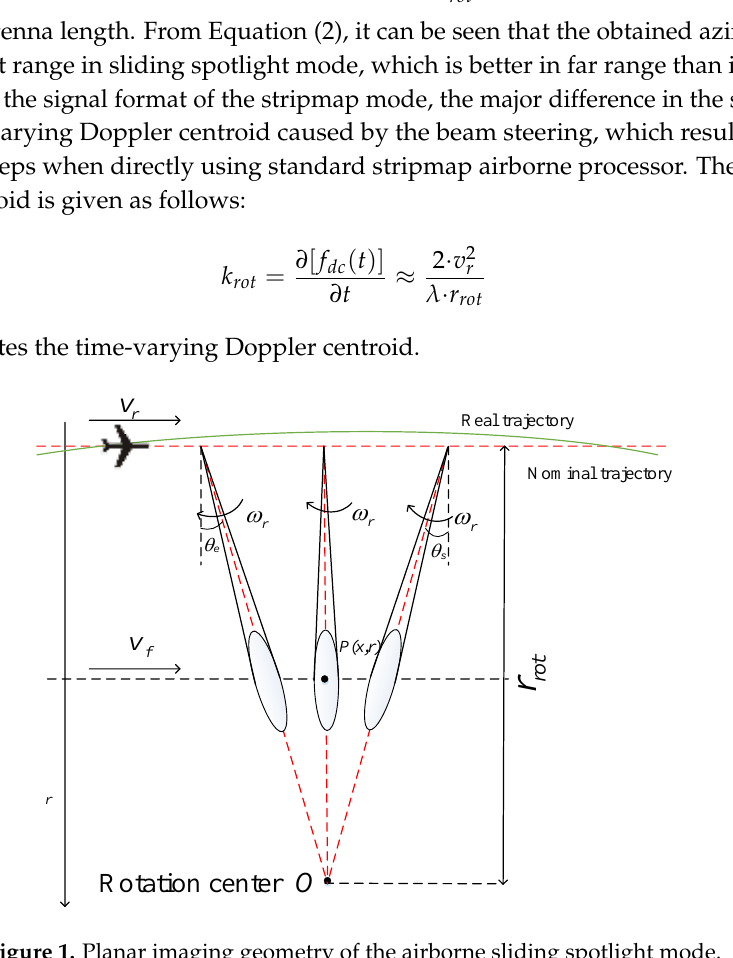
Figure 1. Planar imaging geometry of the airborne sliding spotlight mode.